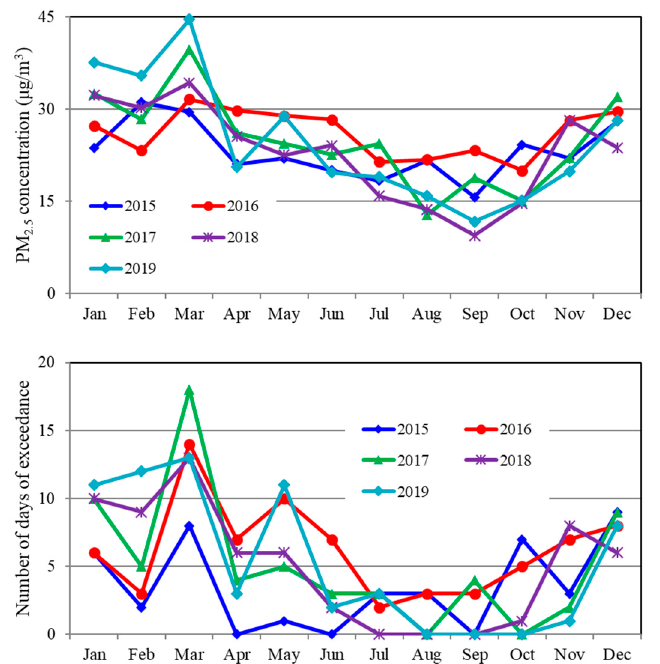
Figure 4. Monthly mean PM 2.5 concentrations ( top ) and the number of days exceeding 35 µ g/m 3 of PM 2.5 ( bottom ) obtained from the Korea air monitoring network in Seoul. Table 1. Annual mean concentrations and the number of days exceeding 35 µ g/m 3 of PM 2.5 in Seoul and Busan. Parameter Annual Mean Concentrations ( µ g/m 3 ) Number of Days Exceeding the PM 2.5 Threshold Year Seoul Busan